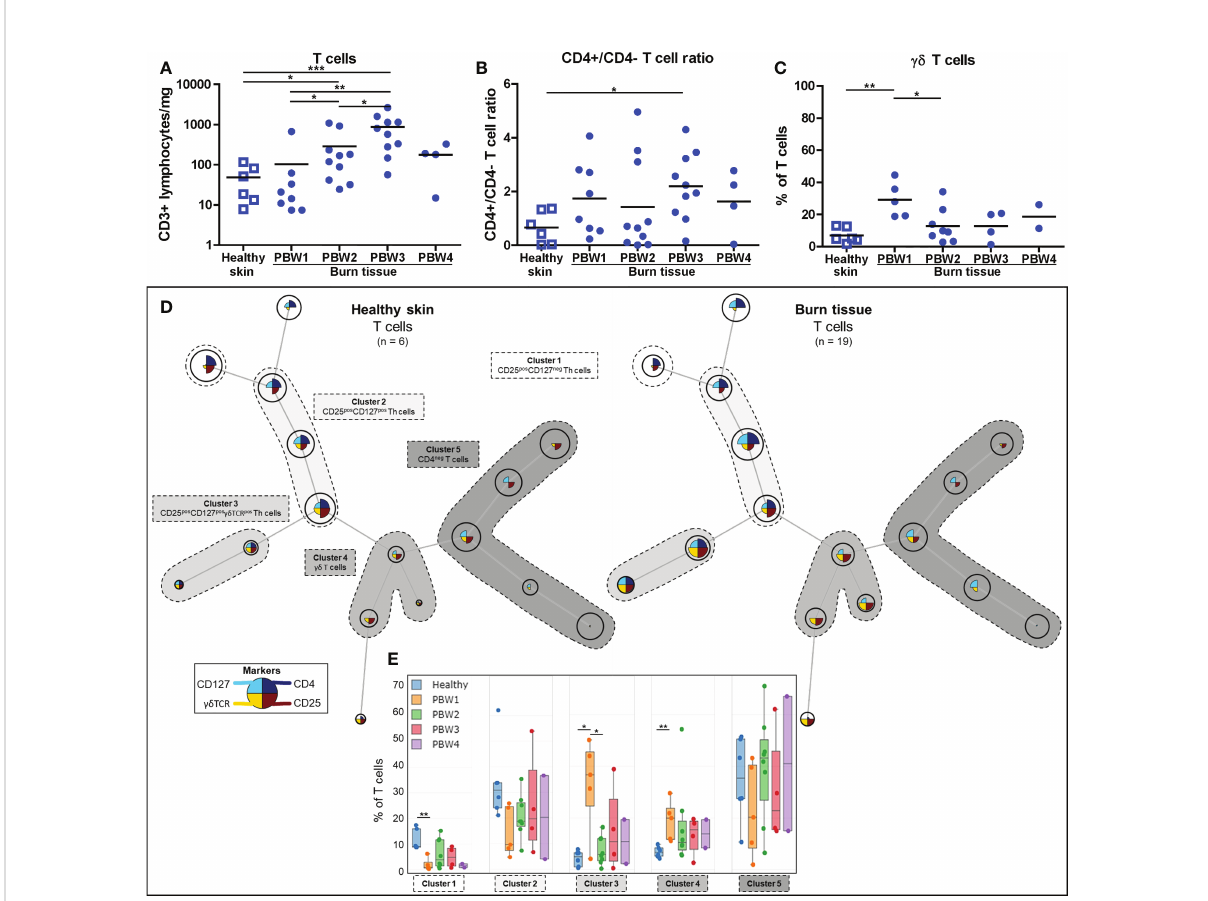
FIGURE 4 Local T cell response to burn injury. Flow cytometry-based quanti fi cation of: (A) Absolute number of T cells (CD3 + lymphocytes) per mg tissue; (B) CD4 + /CD4 - T cell (CD3 + lymphocytes) ratio in tissue; (C) Percentage of T cells (CD3 + lymphocytes) that are gd T cells ( gd TCR + CD4 - T cells). (D) Unsupervised clustering of T cells (CD3 + lymphocytes) in healthy skin and burn tissue, 5 clusters are highlighted. Node size represents relative size of population and node diagram shows expression level of markers. (E) Percentage of T cells within each cluster. Error bars in E show boxplot, p values were calculated using Mann-Whitney U statistical tests, signi fi cant differences are indicated by black asterisks: *p < 0.05; **p < 0.01; ***p <